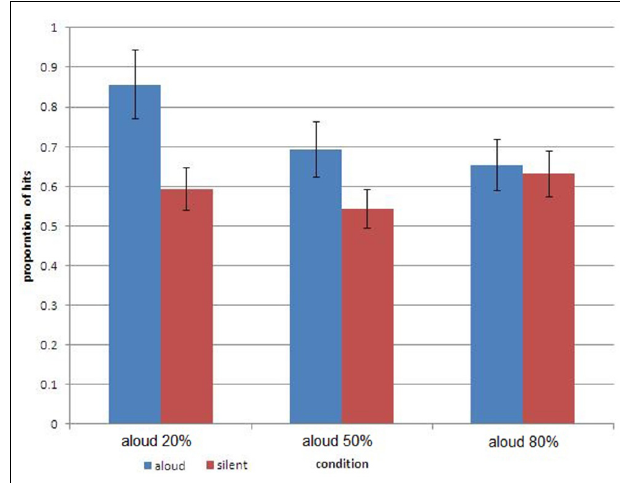
FIGURE 2 | Percentage of correctly recognized words, calculated separately for the subsets of aloud and silent words, in three groups defined by the size of the subset of aloud words. The bars represent one standard error around the